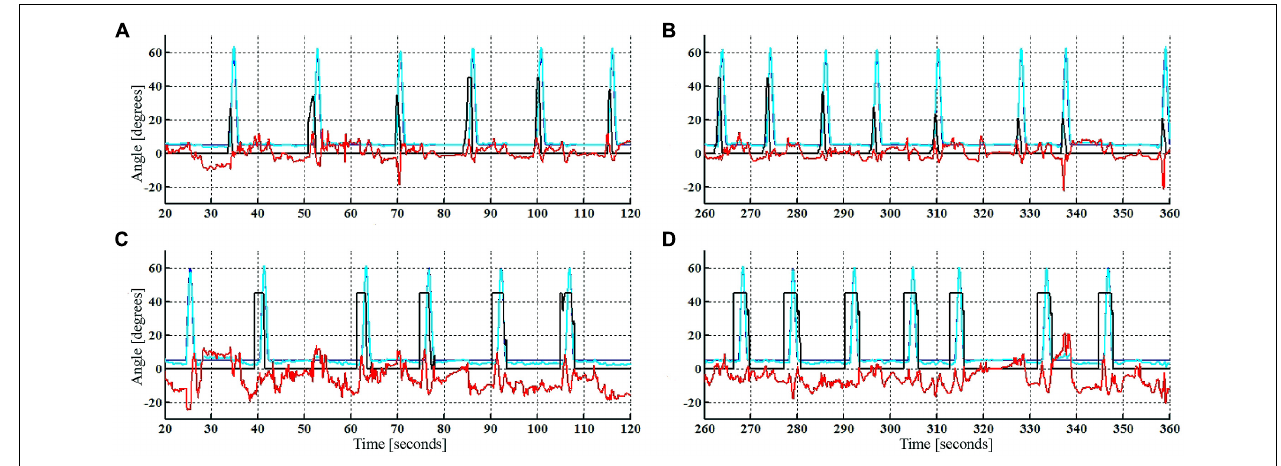
FIGURE 3 | Reference (blue) and actual (cyan) knee joint sagittal angle, interaction forces (red, [N · m/deg]), and ILC stimulation output (black, [ μ s]) during HC walking condition. First steps of left leg (A) , last steps of left leg (B) , first steps of right leg (C) , last steps of right leg (D) .